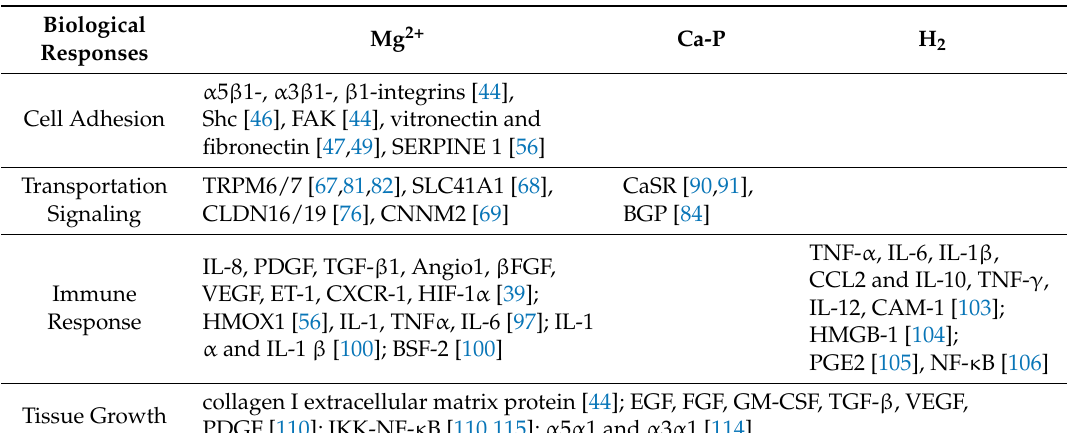
Table 1. Molecular factors involved in or possibly related to the response to magnesium-based materials (MBM) implant corrosion